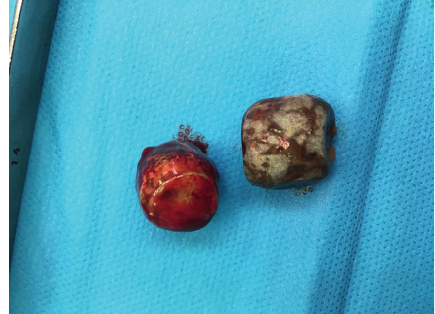
Figure 4: Gallstone removal from the